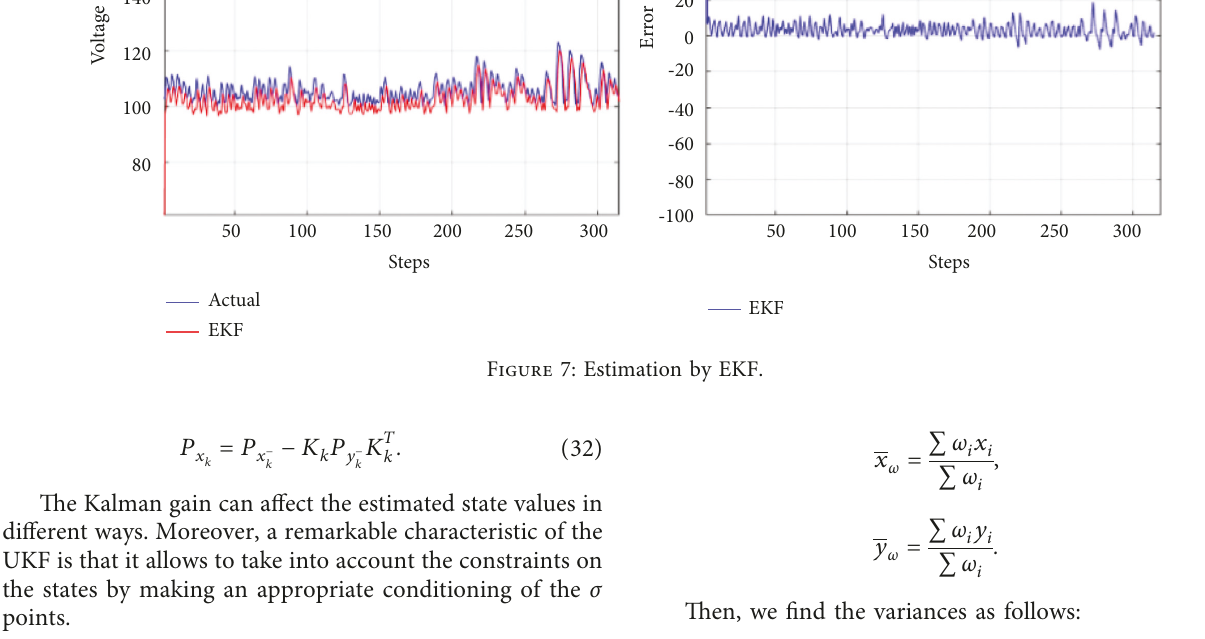
Figure 7: Estimation by